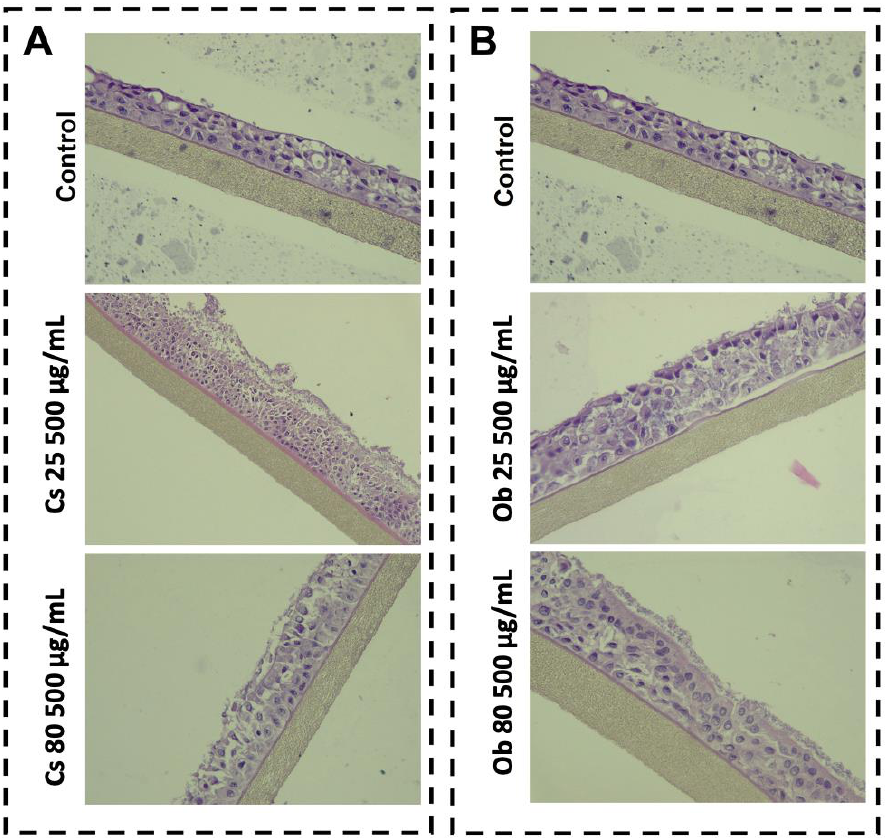
Figure 8. Morphological aspects induced by MNPs based on green tea ( A ) and basil ( B ), on bronchial respiratory tissues.